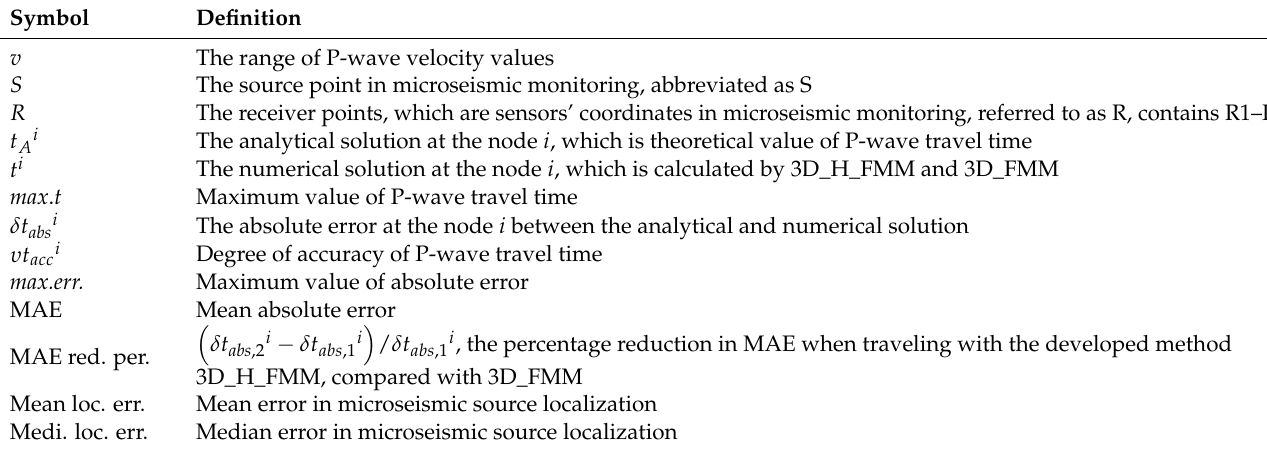
Table 2. The main notations used throughout the